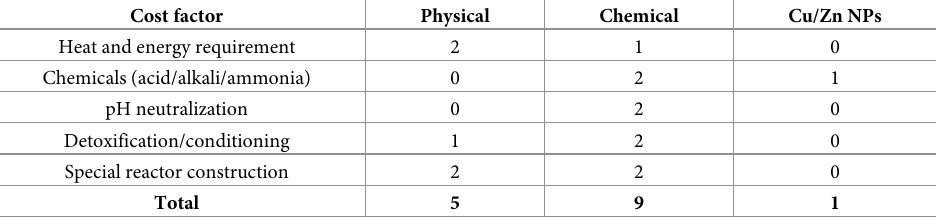
Table 4. Cost factors associated with the disinfection of greywater by Cu/Zn NPs in a comparison to the physical and chemical treatment